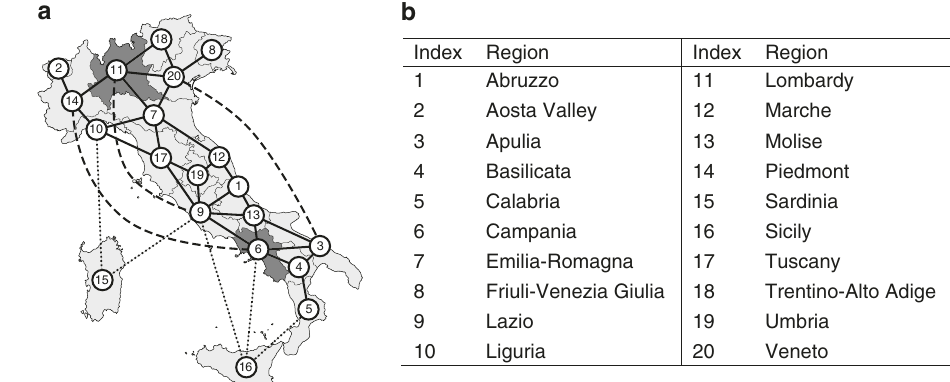
Table 1 Estimated parameter values for Campania in the South (region no. 6) and Lombardy in the North (region no. 11), where the initial outbreak occurred.